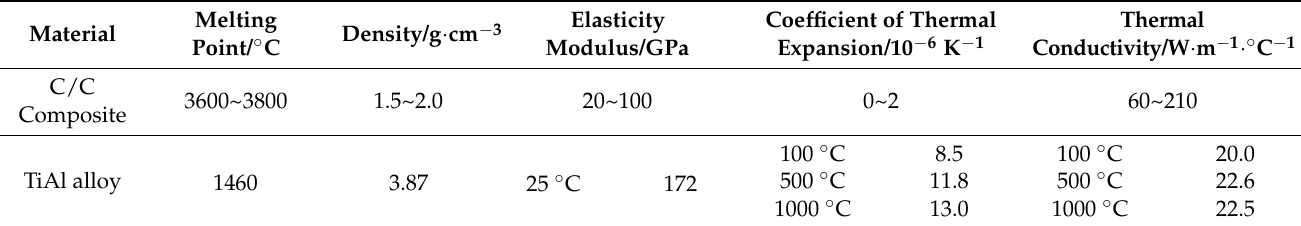
Figure 1. Morphologies of base materials: ( a ) Optical (OM) macro-morphology of C/C composite, ( b ) Backscattered electron (BSE) micromorphology of TiAl alloy. Table 1. Basic properties of C/C composite and TiAl alloy [11,12].